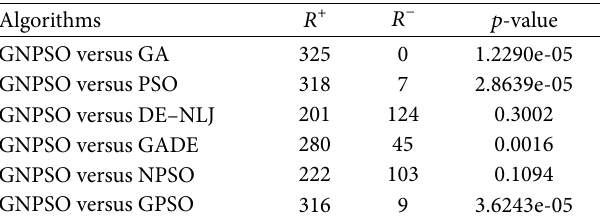
Table 14: Wilcoxon signed ranks test results for the best control performance of MIMO nonlinear wing vibration system with two control surfaces obtained by different